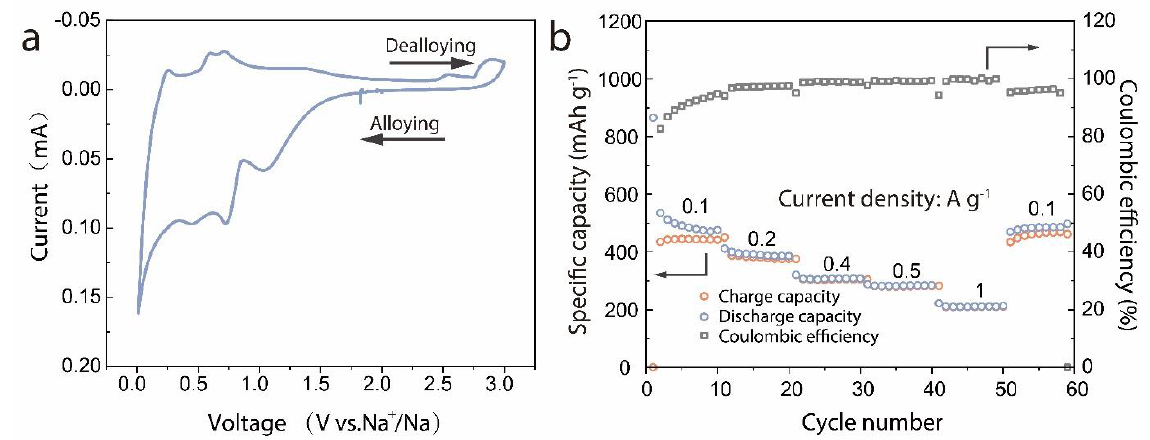
Figure 5. ( a ) CV curves of the Gr-SnO 2 nanoparticles. The voltage window is 3 – 0.01 V. ( b ) Rate performance of the Gr-SnO 2 nanoparticles. Current densities of 0.1, 0.2, 0.4, 0.5, and 1 A·g −1 are used for the cycles.